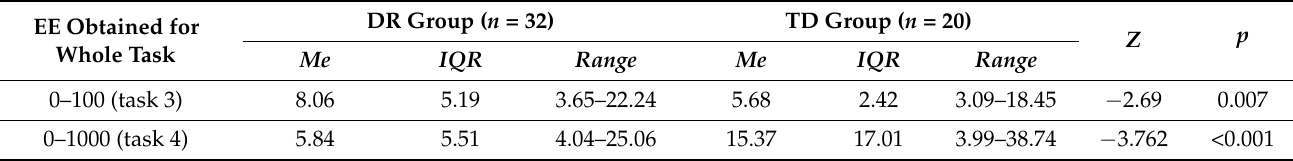
Table 2. Descriptive statistics (median, IQR, and range) calculated for all numbers used in tasks 3 and 4 (0–100 and 0–1000, respectively) obtained in the DR and TD